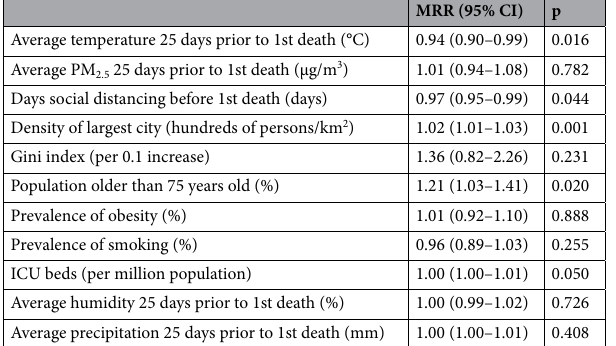
Table 3. Multivariable negative binomial regression model for the mortality at 30 days after the first COVID- 19 death. MRR mortality rate ratio.